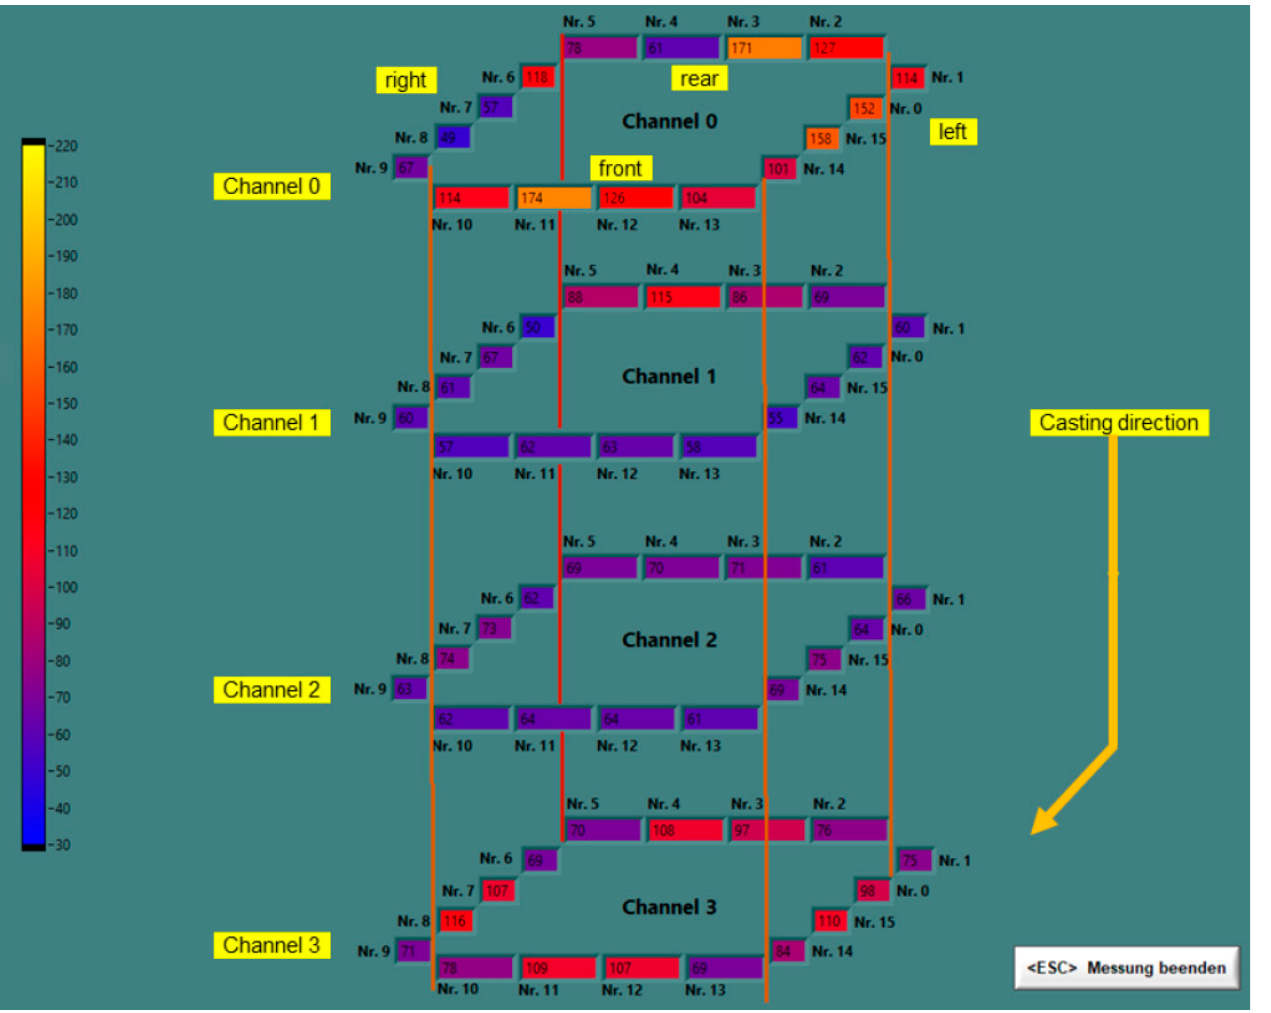
Figure 4. Visualisation of FOTS measurement with layout of 64 sensors along mould walls for ESF caster.